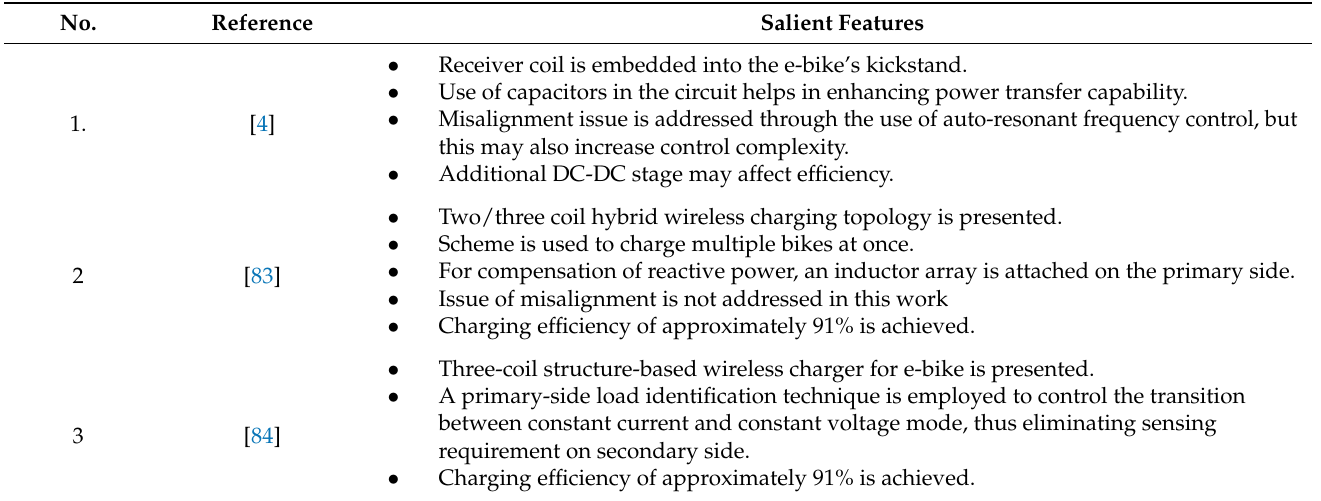
Table 4. Summary of some recent wireless LEV charger